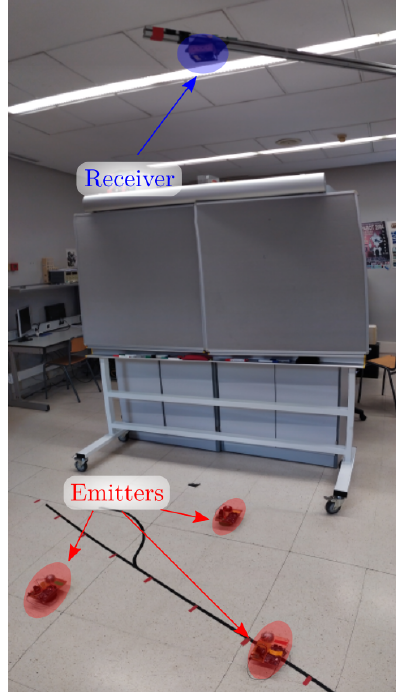
Figure 18. Set-up of the experimental tests.